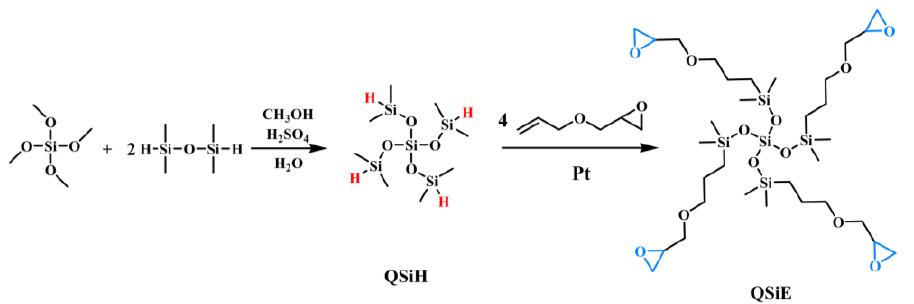
Figure 7. Synthetic route of QSiE.